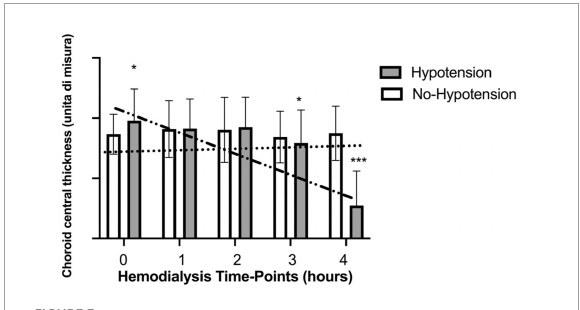
FIGURE3 Variations of choroid central thickness during haemodialysis